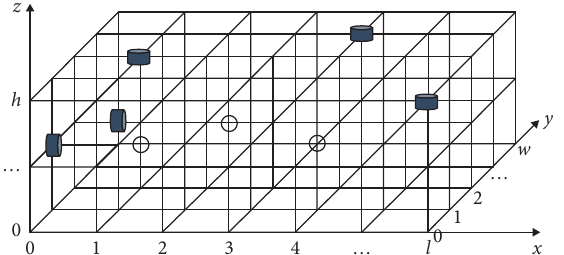
Figure 2: Schematic diagram of the three-dimensional area